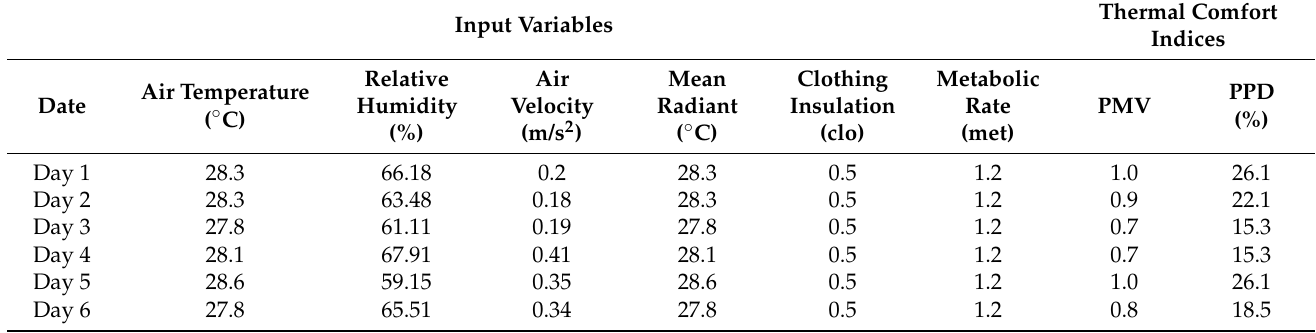
Table 4. Results of field measurements and thermal comfort indices (input variables for PMV and PPD) for HRB2.